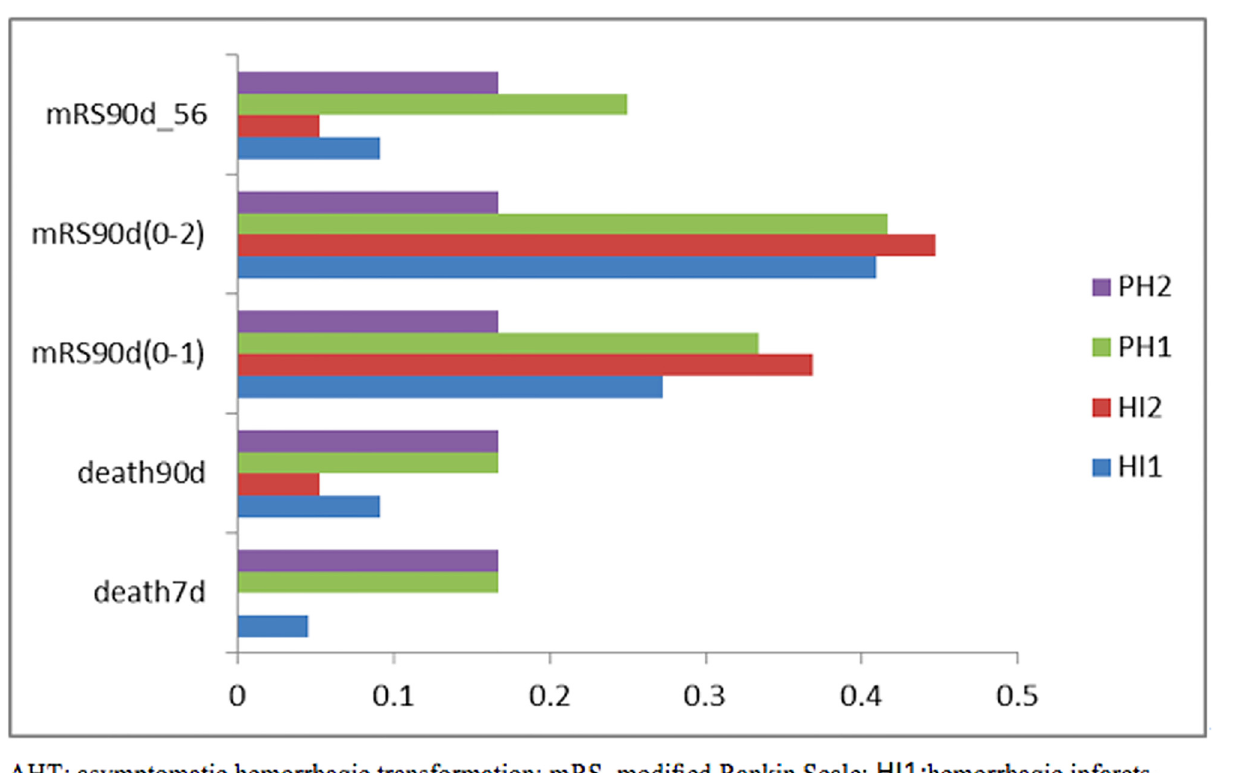
Fig 2. Comparison of function in different subtype of AHT at 7-day and at 90-day in TIMS-china. AHT: asymptomatic hemorrhagic transformation; mRS, modified Rankin Scale; HI1:hemorrhagic infarcts type 1; HI2: hemorrhagic infarcts type 2; PH1: parenchymal hematomas type 1; PH2: parenchymal hematomas type